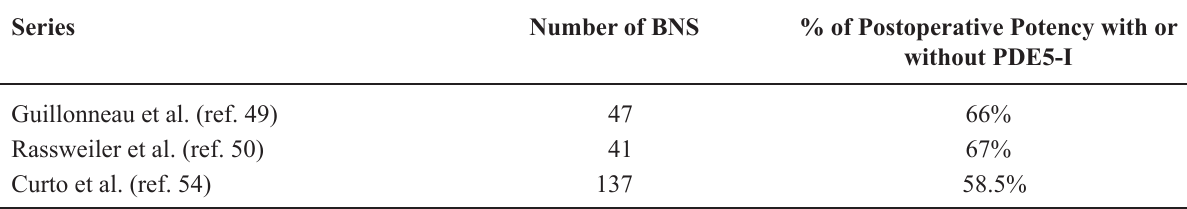
Table 11 – Potency rates (with or without use of PDE5-I) after bilateral nerve sparing (BNS) procedure for patients pre - operatively